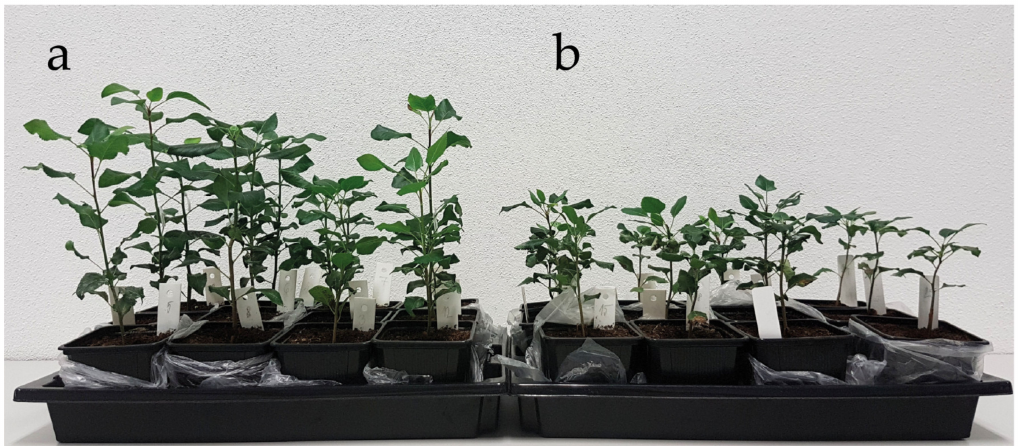
Figure 2. The di ff erences in growth and biomass formation of P.pyraster seedlings grown for 50 days in di ff erent water regimes; ( a ) control plants; ( b ) plants under drought treatment.